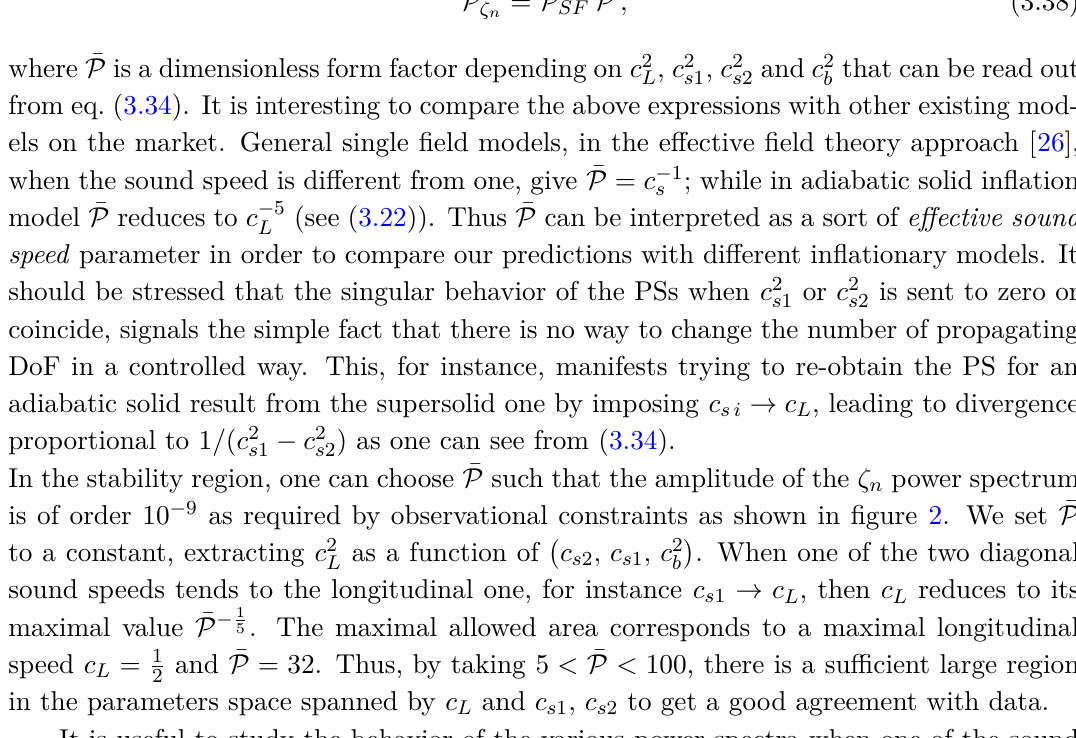
¯ (cid:1) . The contour plot for ¯ as a function of (cid:0) c Figure 2. c 2 P s 1 , c s 2 , L allowed region. The green curve represents the area covered for smaller values of ¯ P while the red one shows higher value of ¯ P